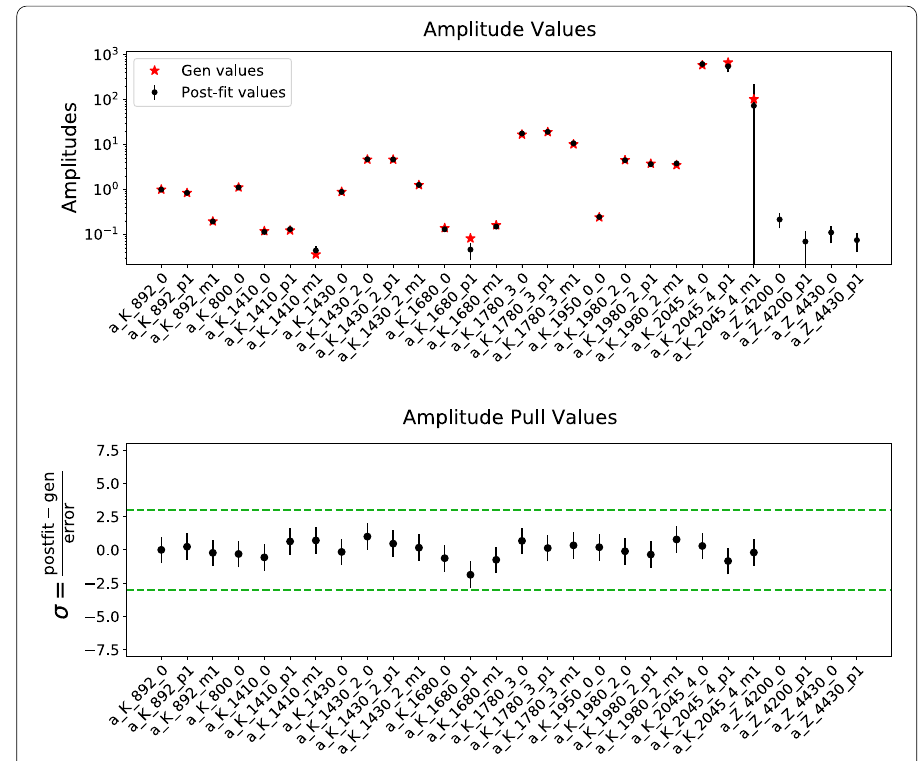
Fig. 7 Comparison of generated and post-fit values of the amplitude parameters (above) and the corresponding pull distribution (below) obtained when a dataset generated with ten K ∗ s is fitted with the [ten K ∗ s Z (4200) Z (4430)] model. The green lines define a ± 3 σ band. The pulls for the Z components are + + not defined because the Z s are not present in the generation